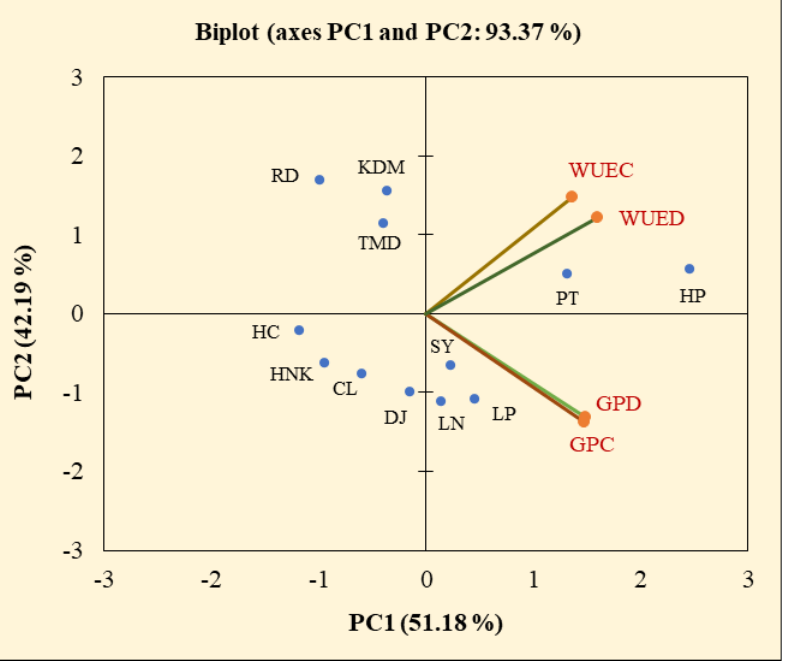
Figure 7. Principal component analysis (PCA) biplot of grain productivity under control (GPC), grain productivity under drought stress (GPD), water use efficiency under control (WUEC) and water use efficiency under drought stress (WUED) for twelve lowland rice cultivars. RD: RD − 15, KDM: Khao Dawk Mali − 105, TMD: Tia Malay Dang, PT: Pathum Thani − 1, HP: Hom Pathum, HC: Hom Chan, HNK: Hom Nang Kaew, CL: Chor Lung, DJ: Dum Ja, SY: Sang Yod, LN: Lep Nok, LP: Look Pla.